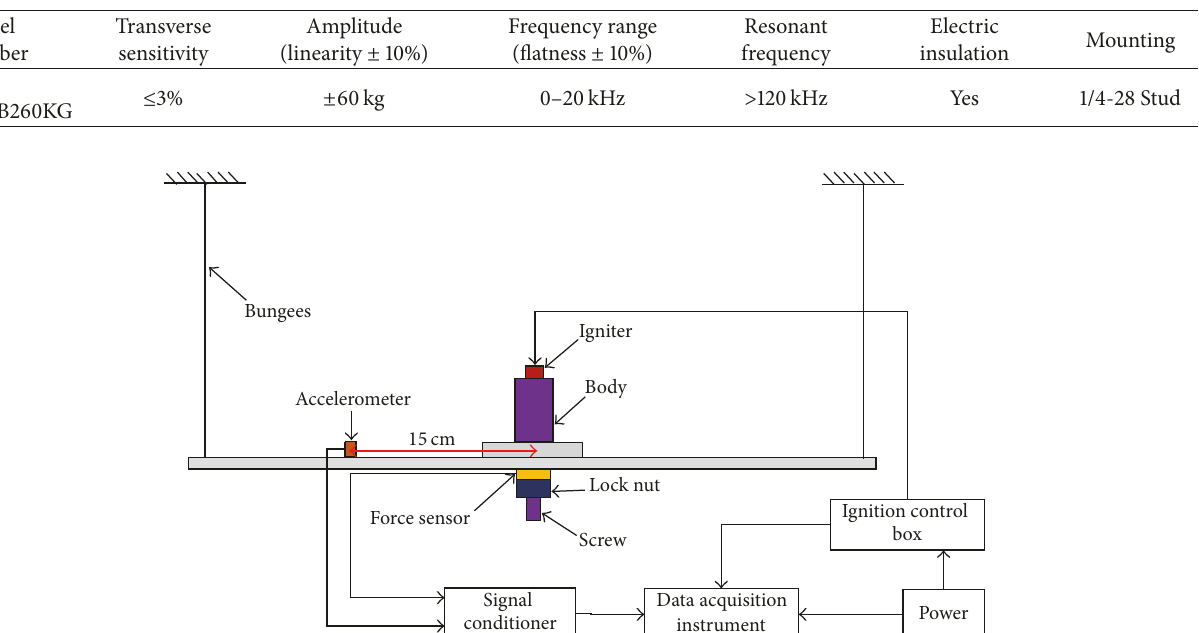
Table 1: Performance parameters of accelerometer.